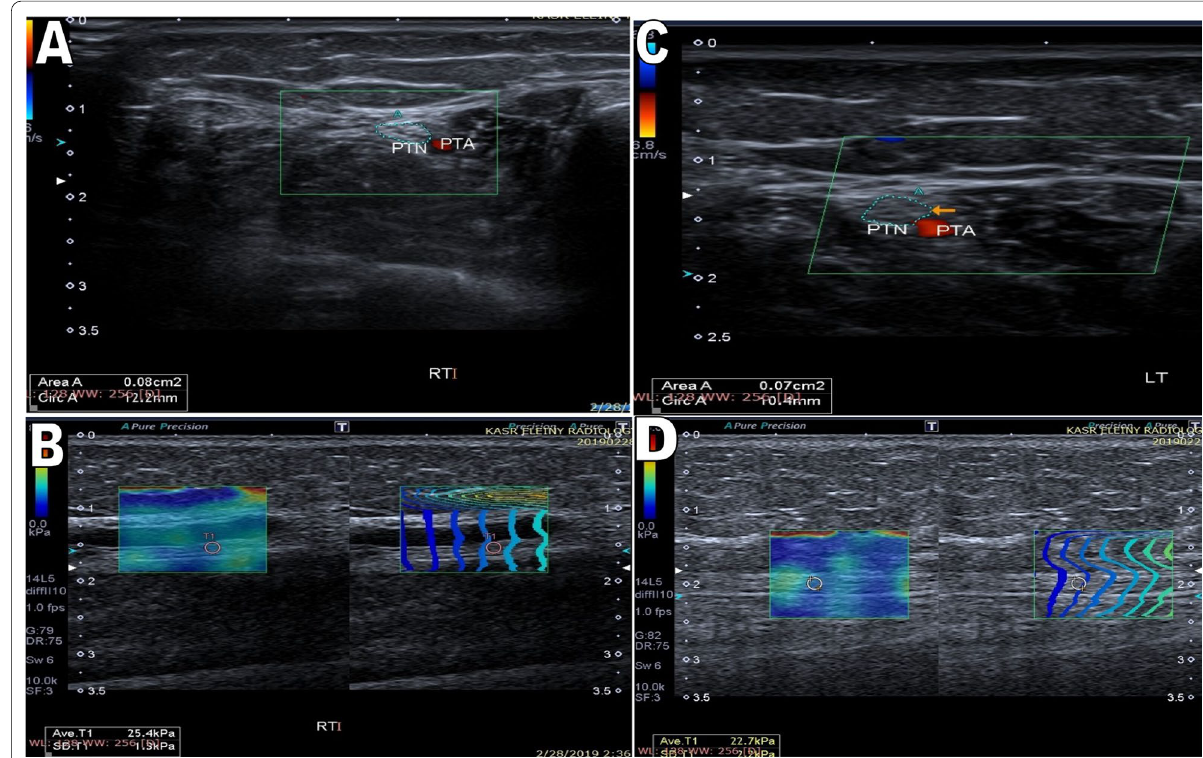
Fig. 4 A 30-year-old female patient not diabetic and not complaining of any chronic disease with normal nerve conductive study. A The right PTN in relation to the PTA with its CSA measuring 8 mm 2 . B The right image is the B-mode, and the left image measures the elasticity of the PTN (25.4 kPa) with a color-coded box, circular ROI (T1) for quantitative measurements and a color code scale at the top side of the image. C The right PTN in relation to the PTA with its CSA measuring 7 mm 2 . D The right image is the B-mode, the left image measures the elasticity of the PTN (22.7 kPa) with a color-coded box, circular ROI for quantitative measurements, and a color code scale at the top side of the image. Normal CSA and nerve stiffness matching the clinical and nerve conduction